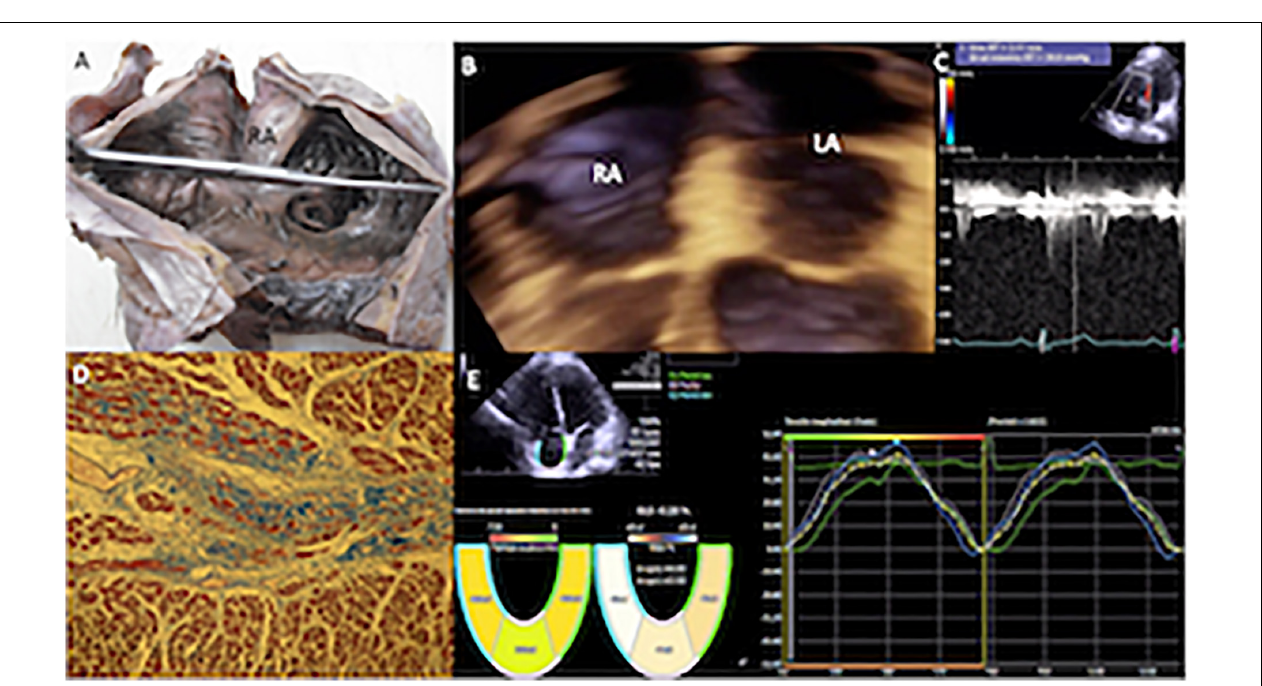
FIGURE 2 | (A) Specimen showing the internal appearance of the dilated right atrium, the pectinate portion that continues with the appendage is observed to the right of the observer, and the anterior leaflet of the tricuspid valve is observed below. (B) Transthoracic 3D echocardiogram in four-chamber view with mild enlargement of the right atrium. (C) Mild pulmonary hypertension (PH) systolic pulmonary arterial pressure (sPAP) of 44 mmHg. (D) Histological study (stained with Masson, 10 × ) of the atrial myocardium of a patient, with mild PH. The muscle fascicles were mostly cut transversely or obliquely. Two muscle fascicles are replaced by fibrous connective tissue rich in collagen fibers that stain blue, and contrast with the red in which the myocardium is stained. One fascicle is partially replaced by collagen and another almost entirely. The degree of fibrosis in the observed fields was calculated at 25%, since in this image it could reach a little more than a quarter. (E) Echocardiography with velocity vector imaging of a patient with a low probability of PH, who had a normal global longitudinal strain of the right atrium (43.5%). RA, right atrium; RV, right